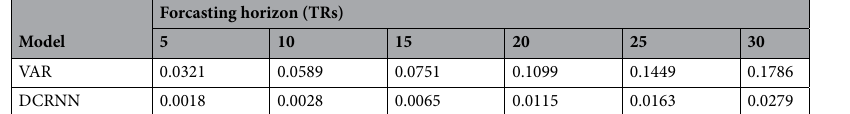
Table 1. The overall test MAE of the VAR and DCRNN model, in dependence of different forecasting